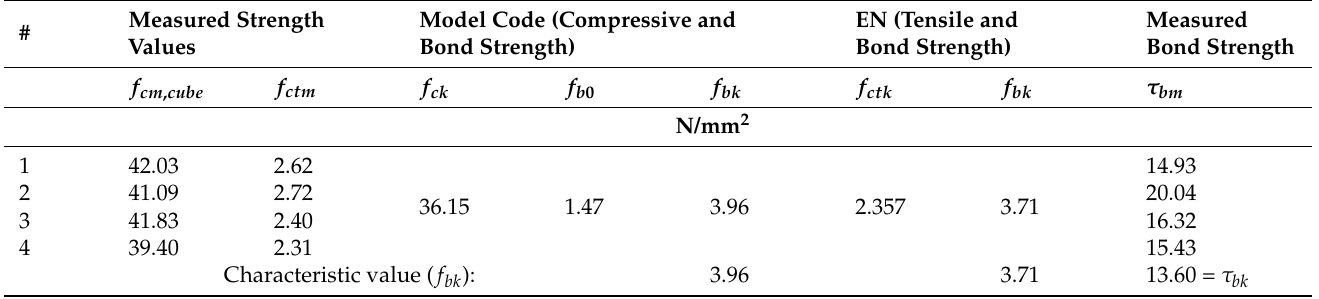
Table 3. Comparison of the characteristic values of the standards and our measurements.